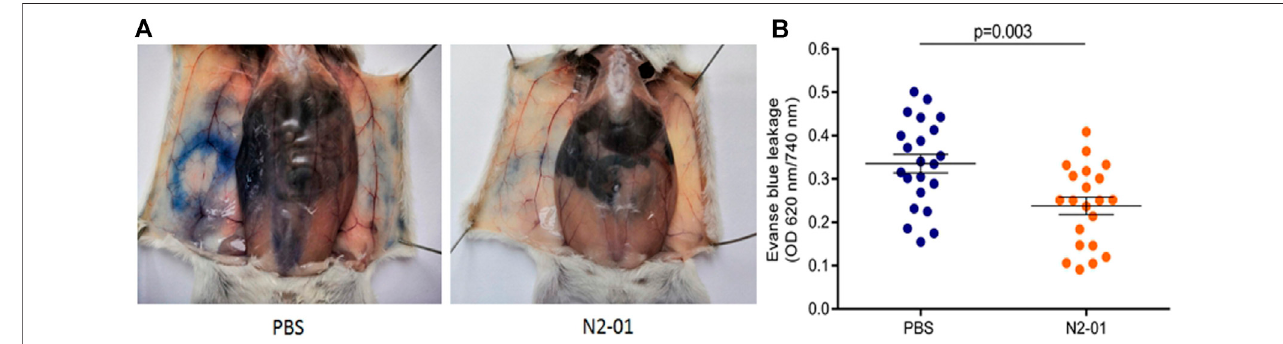
FIGURE 10 | The effect of N2-01 on vascular permeability A, B. Note. Statistical assessment of differences was performed using Student`s t -test. The data are presented as mean ± SEM ( n (cid:2)